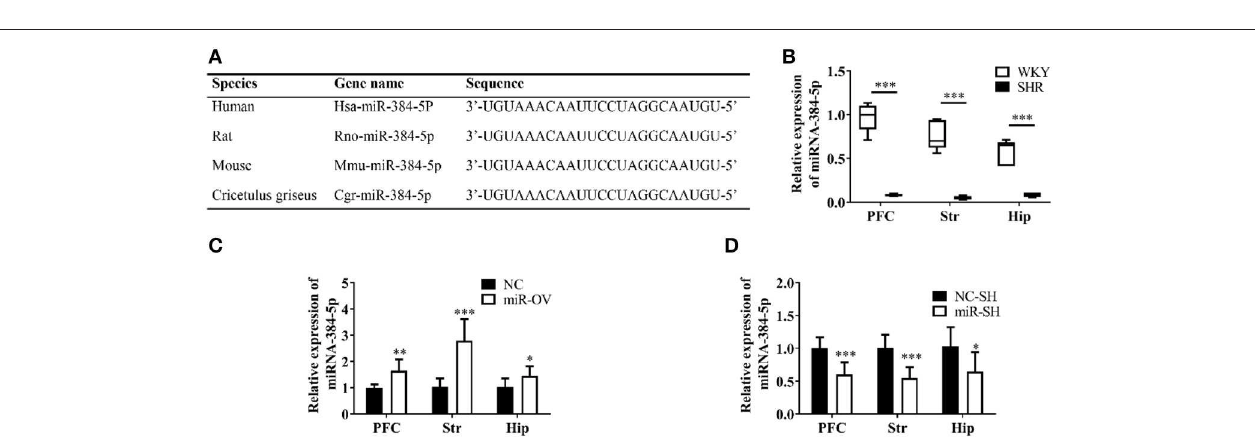
FIGURE 1 | Analysis of miR-384-5p, a small non-coding RNA. (A) Conservation and homology of miR-384-5p in humans, mice, rats, and Chinese hamsters ( Cricetulus griseus ). (B) Relative expression of miR-384-5p in the PFC, Str, and Hip of WKY and SHR rats. (C,D) Relative expression levels of miR-384-5p that was overexpressed (C) or inhibited (D) in different brain areas, compared with control groups. * P < 0.05, ** P < 0.01, *** P <